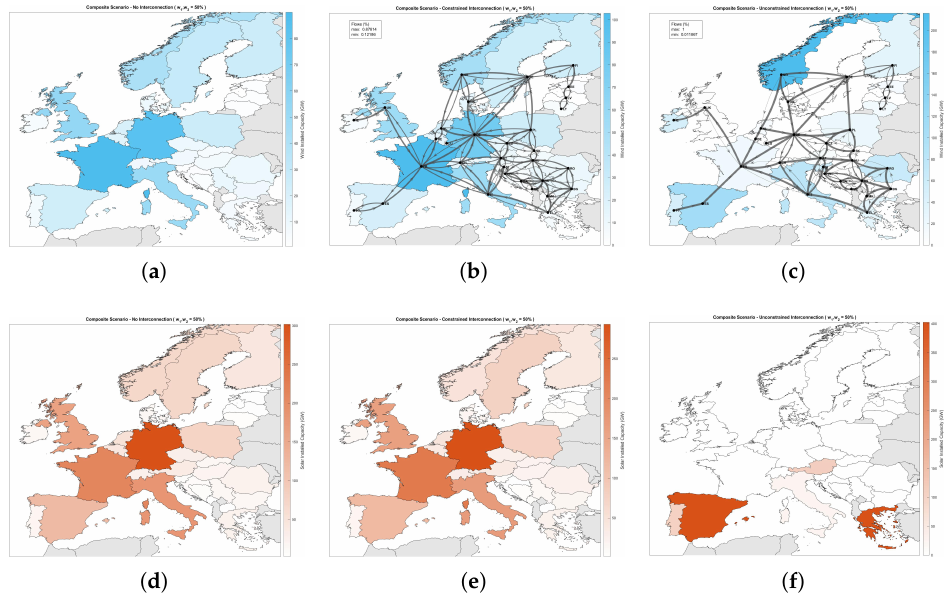
Figure 10. Optimal capacity allocation and cross-border energy flows for the case of composite power portfolios: wind ( a ) and solar ( d ) capacity of in the case of no interconnection, wind ( b ) and solar ( e ) capacity in the case of constrained interconnection and wind ( c ) and solar ( f ) capacity in the case of unconstrained interconnection scenario.